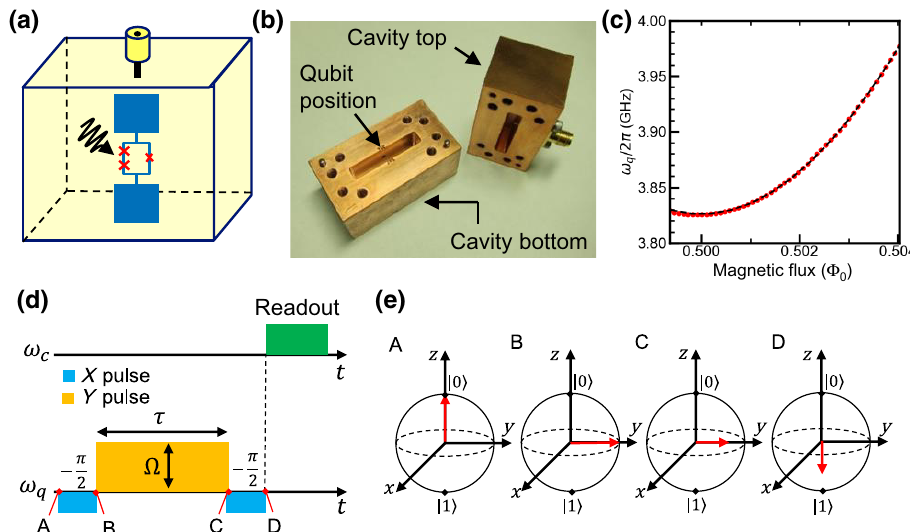
FIG. 3. (a) Schematic of a c-shunt flux qubit embedded inside a 3D microwave cavity. (b) Photograph of the 3D microwave cavity. (c) Qubit spectrum as a function of an applied magnetic flux in units of the magnetic flux quantum (cid:5) 0 . Red dots represent the experimental data. The error bars are within the dot size (the frequency fitting error is less than 0.1 MHz). The dashed black line corresponds to results of numerical simulations using the scQubits package. (d) Schematics of microwave pulse sequences used for the cavity readout (top) and qubit drive (bottom). (e) Bloch-sphere representation of qubit state vectors at different stages of the spin-locking pulse sequence A, B, C, and D shown in Fig.